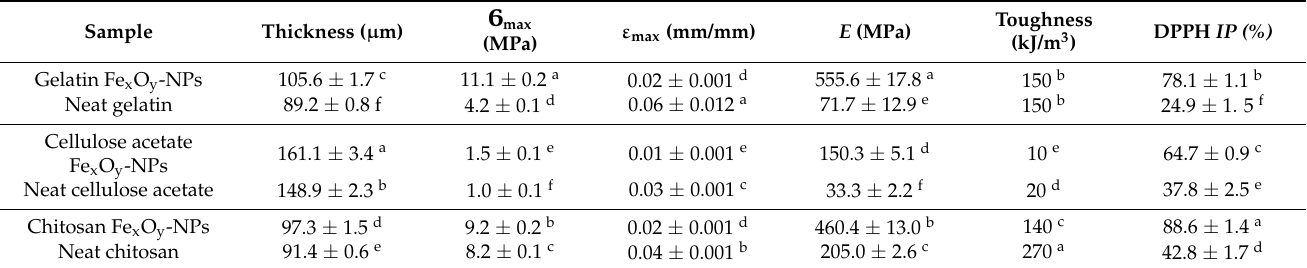
Table 2. Results for thickness, mechanical parameters (